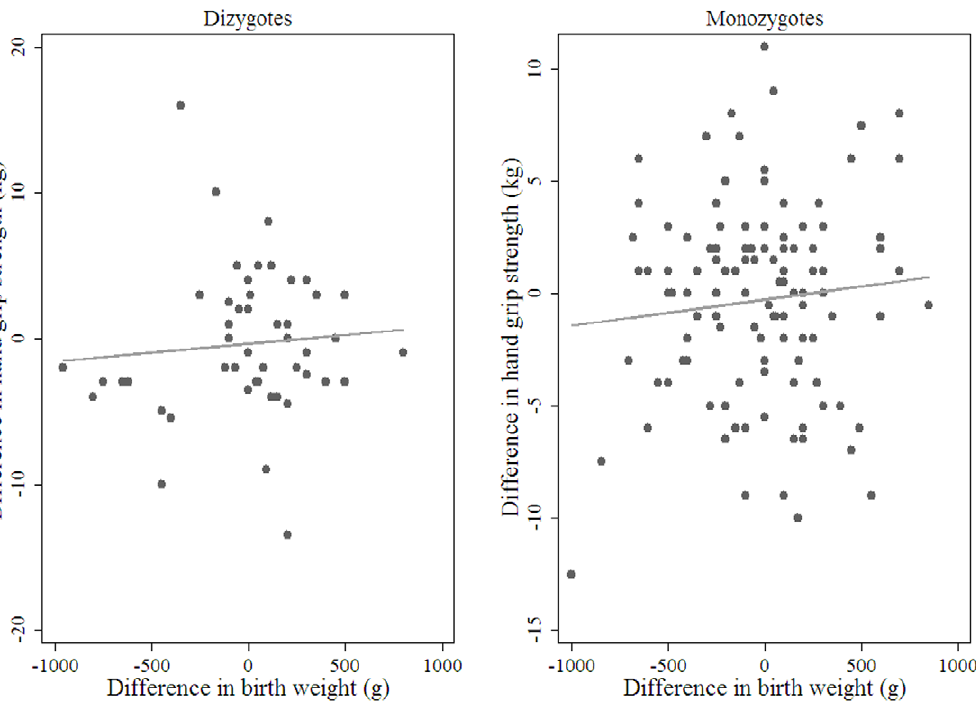
Figure 2. Between pair difference in birth weight and between pair difference in adult hand grip strength in women n=170 female pairs (n=48 DZ, n=122 MZ).